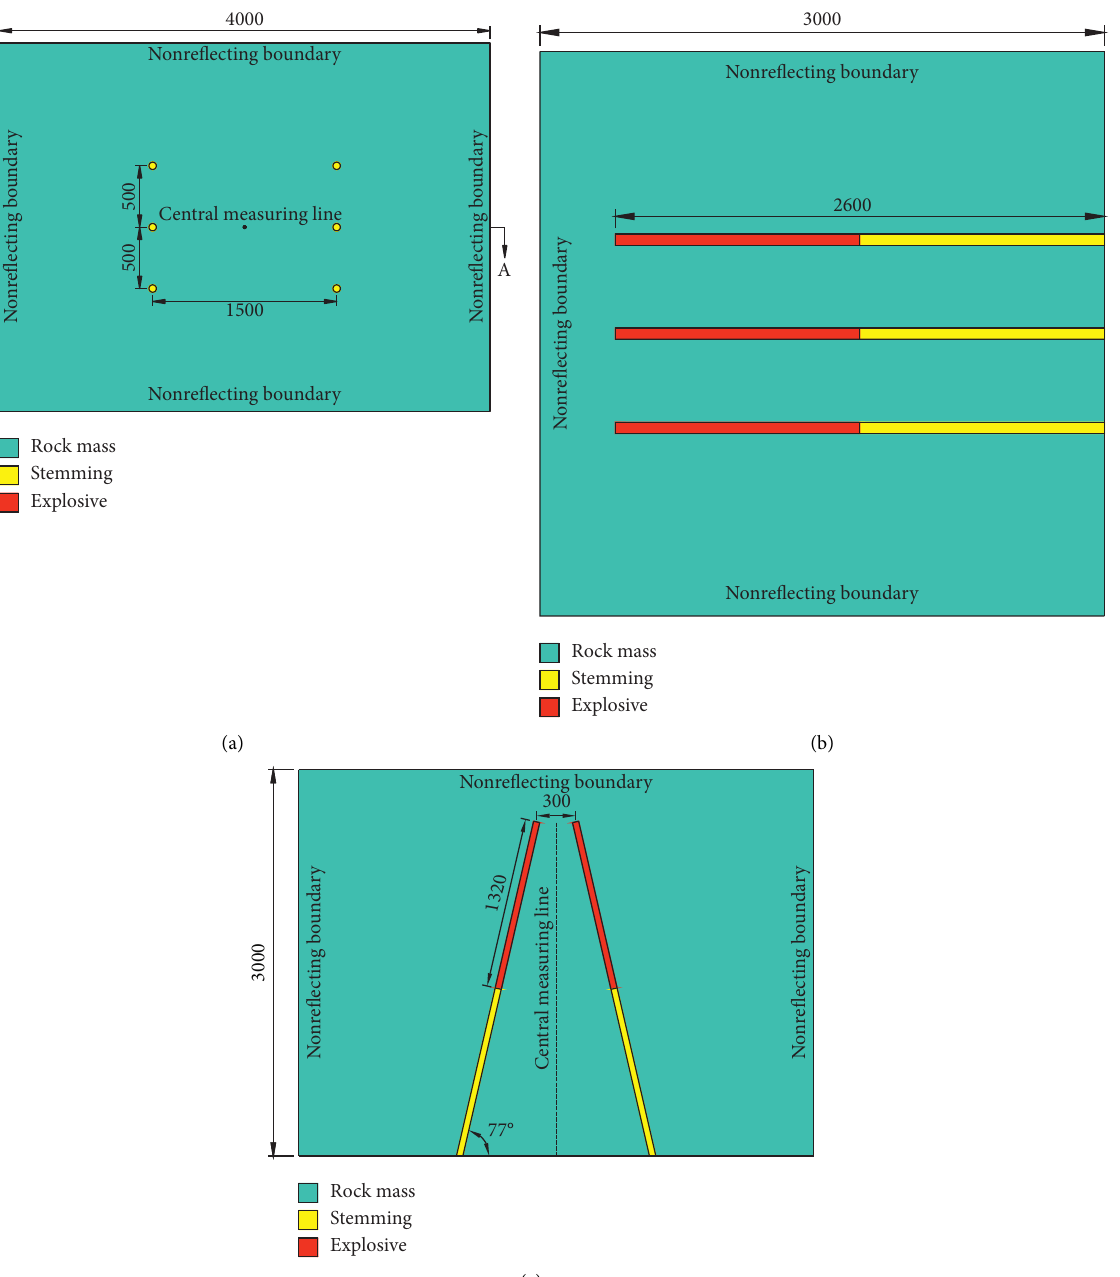
Figure 3: Numerical model of wedge cut blasting (unit: mm). (a) Front view. (b) Left view. (c) Top view (or A-A